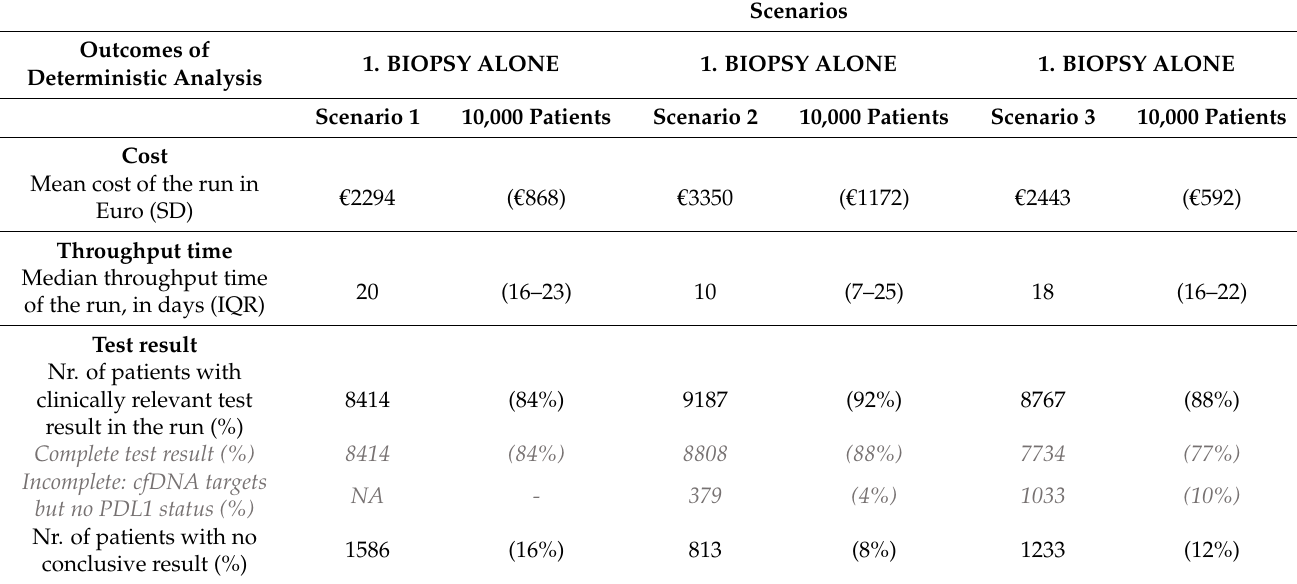
Table 1. Deterministic results of one simulation run of 10,000 cases per scenario.